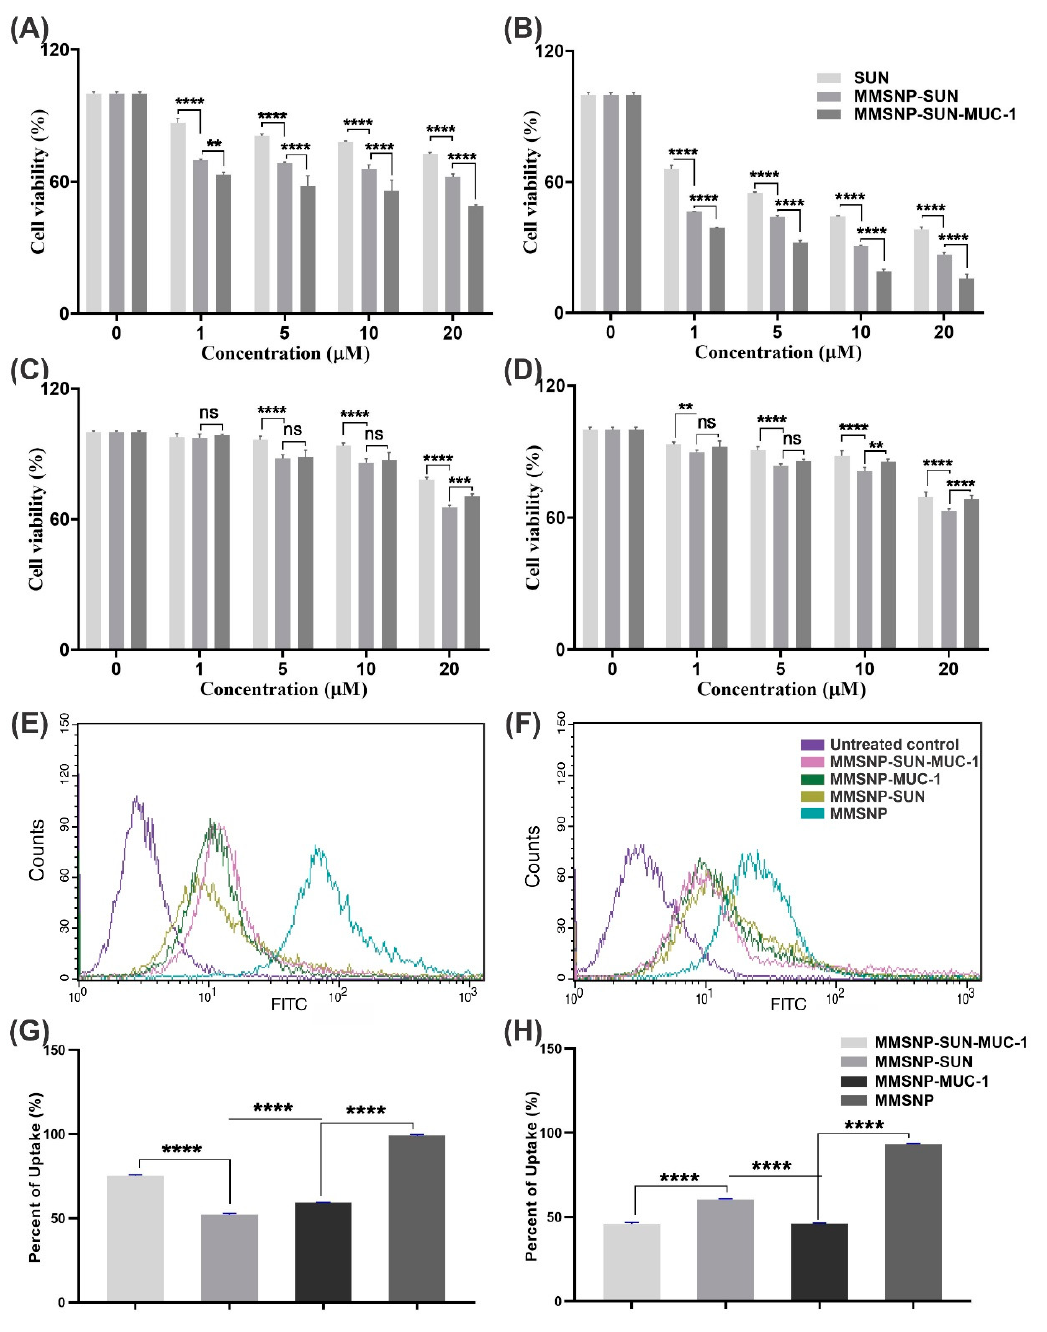
Figure 3. Dose- and time-dependent cytotoxicity of MMSNP-SUN-MUC-1, MMSNP-SUN, and SUN in OVCAR-3 cells and MDA-MB-231 cells, respectively after 24 h ( A , C ) and 48 h ( B , D ). The flow cytometry analysis of MMSNP-SUN-MUC-1, MMSNP-SUN, MMSNP-MUC-1, and MMSNP uptake in OVCAR-3 cells and MDA-MB-231 cells, sequentially ( E , F ). Quantification and comparison of